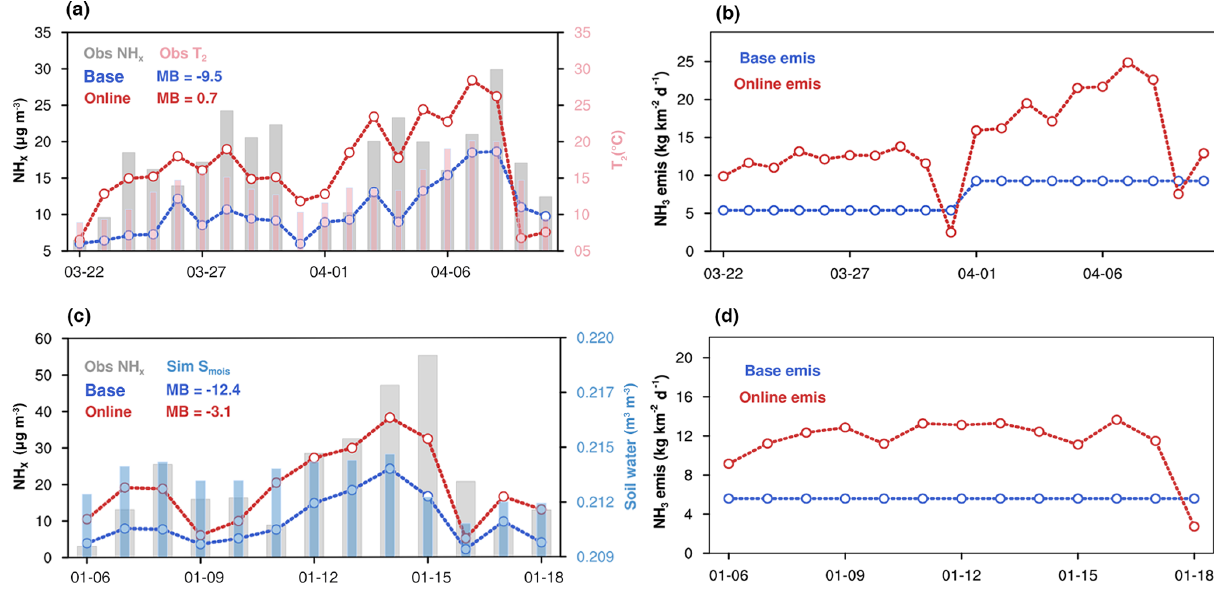
Figure 8. (a) Time series of total ammonia (NH x ) concentrations (gray bar) from 22 March to 11 April 2019 in the Nanjing site. The T 2 (pink bar) represents the air temperature at 2m ground level from the local site. (b) Daily NH 3 emission rate, same as (a) in the Nanjing site. (c) Time series of NH x concentrations (gray bar) from 6 to 18 January 2015 in the Beijing site; S mois (blue bar) represents the top 5cm thick layer soil water which is derived from the WRF model calculations. The mean bias of modeled concentrations is labeled as MB. (d) Daily NH 3 emissions rate, same as (c) in the Beijing site. Blue lines represent the MEIC NH 3 emission used in the base simulation, red lines represent online emissions from